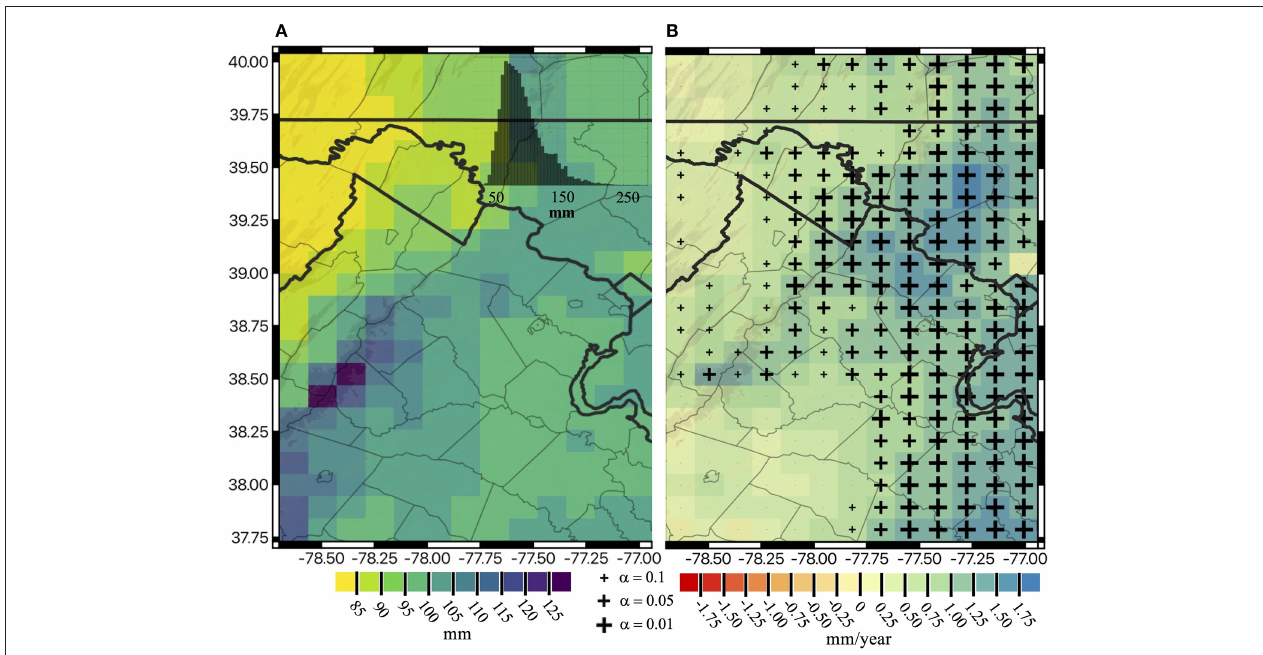
FIGURE 9 | Spatial distribution of extremes and associated trends (1980–2018) for (A) average 5-day annual maximum precipitation with a histogram in the right corner showing a right skewed distribution of the 5-day maximum precipitation; and (B) Theil-Sen 5-day maximum annual precipitation trend. Cold colors indicate a wet trend, whereas warm colors refer to dry trends. The size of the cross markers shows the three significance levels used to perform a Mann-Kendall test on the Theil-Sen trends. Markers are not shown in grids with non-significant trends.